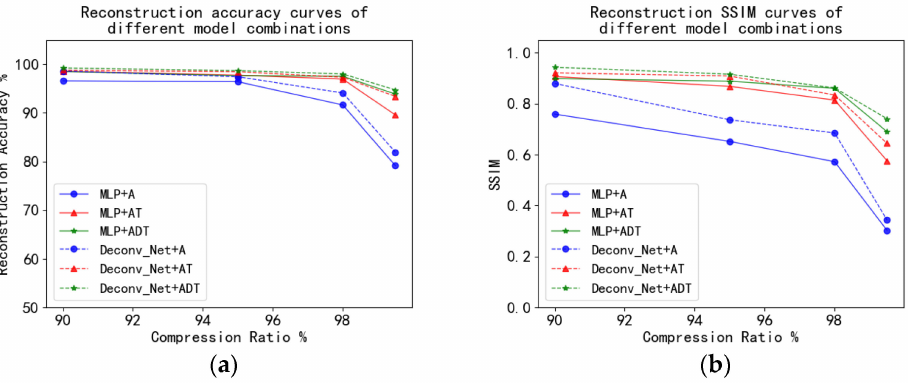
Figure 7. Reconstruction accuracy ( a ) and SSIM ( b ) curves of different model